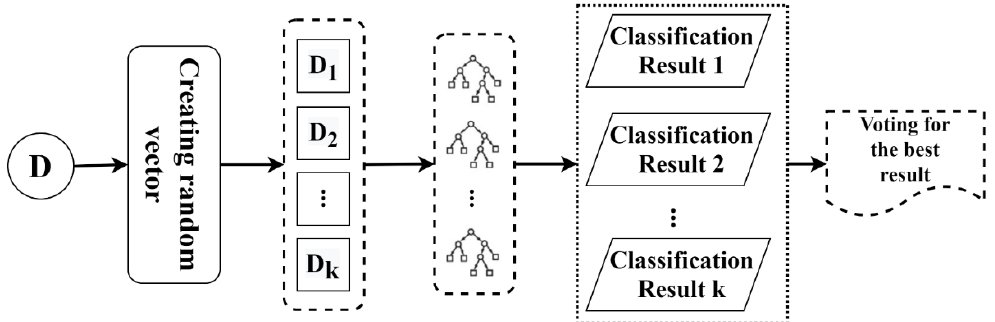
Figure 4. Conceptual scheme of RF model for classification process.